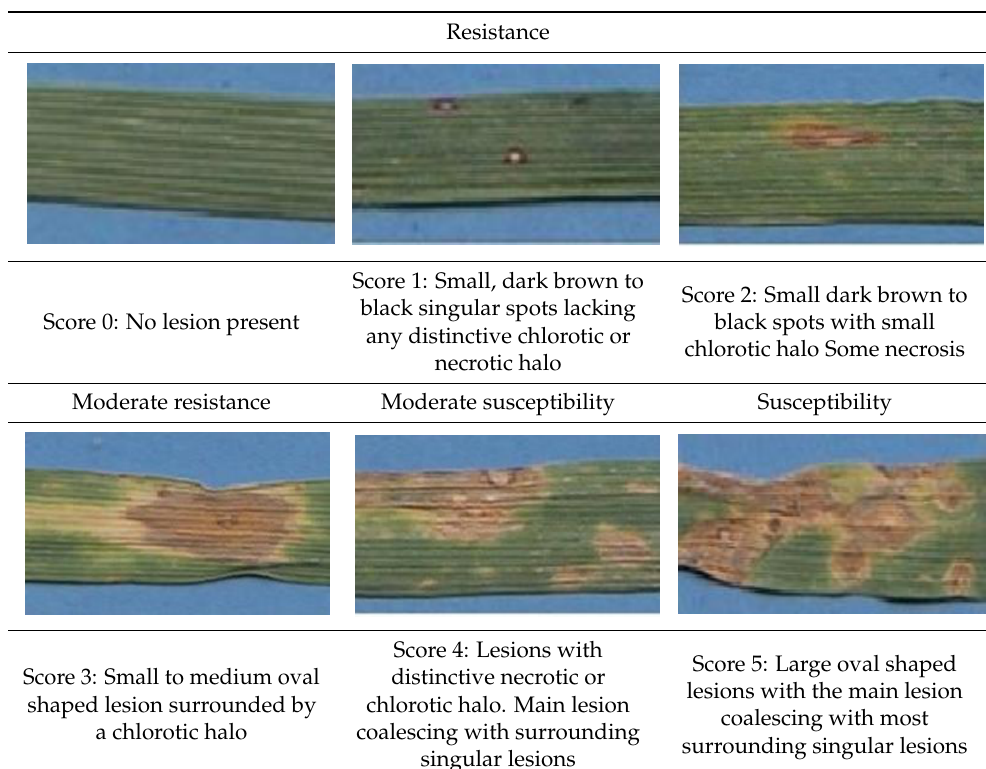
Table 1. Disease score (0 – 5 scale) based on lesion appearance used to assess the severity of Pyre- nophora tritici-repentis